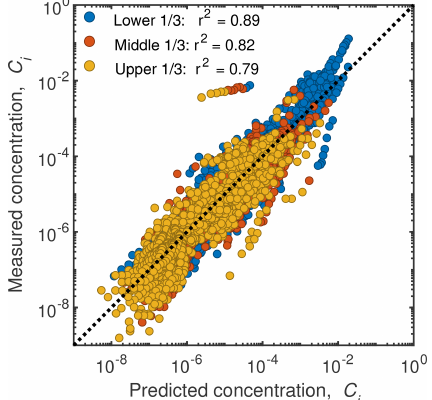
Figure 11. Measured versus predicted grain-size-specific concen- tration for each sample in the water column. Colors indicate the relative elevation in the water column of each sample. The pre- dictions are from the two-parameter model to predict the entrain- (cid:18) (cid:19) (cid:16) u (cid:17) 1 . 77 ∗ skin Fr 1 . 18 E s i = 4 . 74 × 10 − 4 ment rate and the one- w s i (cid:16) (cid:17) P i = ( u ∗ /w s i ) − 0 . 45 parameter model for the Rouse number .